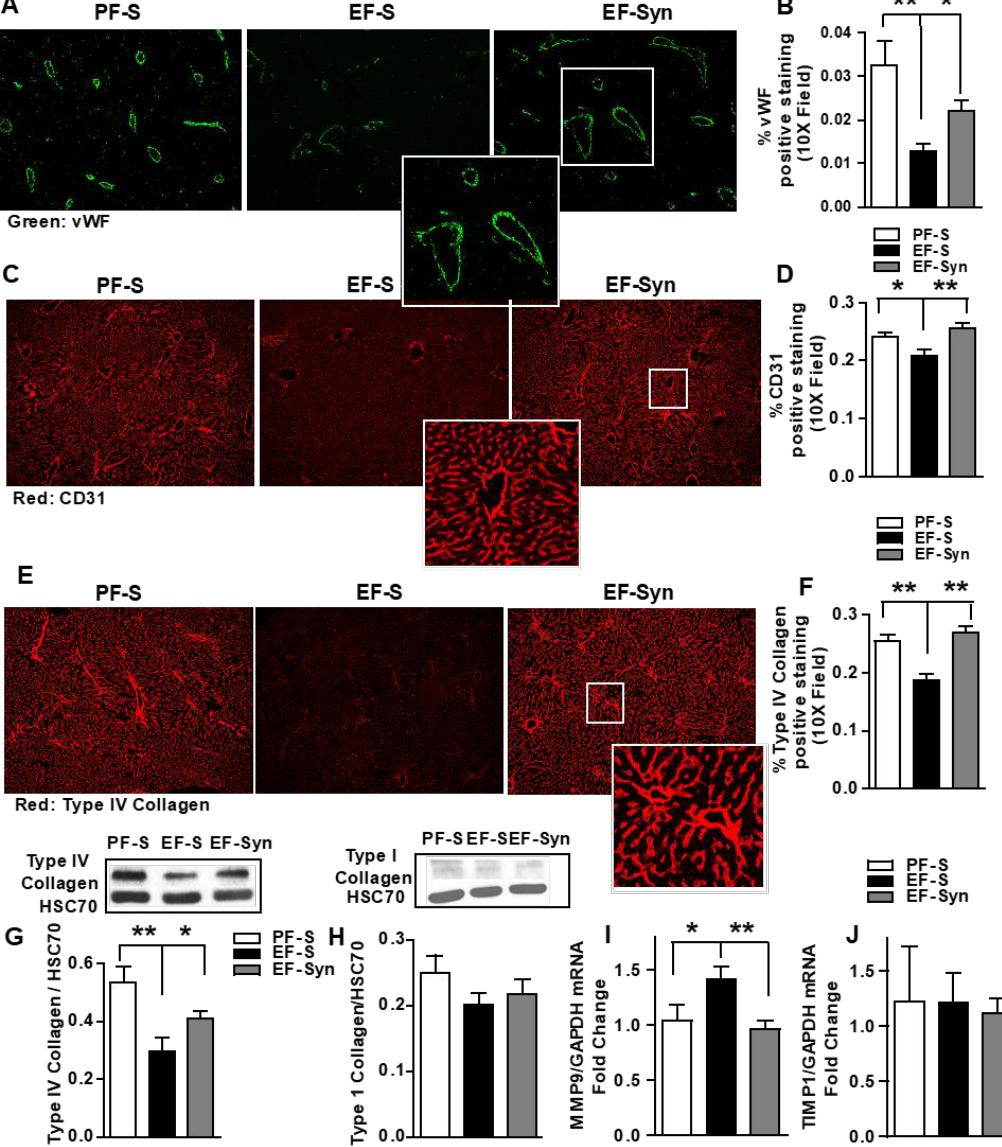
Figure 5. Effect of synbiotic on hepatic vasculature. Mice were treated as described in Figure 1. Upon euthanasia, the liver was dissected and flash frozen for immunoblotting or fixed in formalin and paraffin embedded for immunohistochemical analysis, histology, or RNA was prepared and used for qRT-PCR analysis. The liver sections were probed for the following: ( A,B ) von Willebrand Factor (vWF; green); ( C,D ) CD31 (red); ( E–G ) Type IV Collagen (red); ( H ) Type I Collagen; ( I ) MMP9 mRNA and ( J ) TIMP1 mRNA expression in liver, and presented as fold change. All images were acquired using a 10× objective, and a selected area was cropped and enlarged. Images are representative of at least replicate images captured per mouse in 8 to 12 mice per treatment group. Immunofluorescent images were semi-quantified, and immunoblot band densities were analyzed using ImageJ software and normalized to HSC70. Values represent means ± SEM. * p < 0.05; ** p < 0.001. Pair-fed saline (PF-S); Ethanol-fed saline (EF-S); Ethanol-fed synbiotic (EF-Syn).